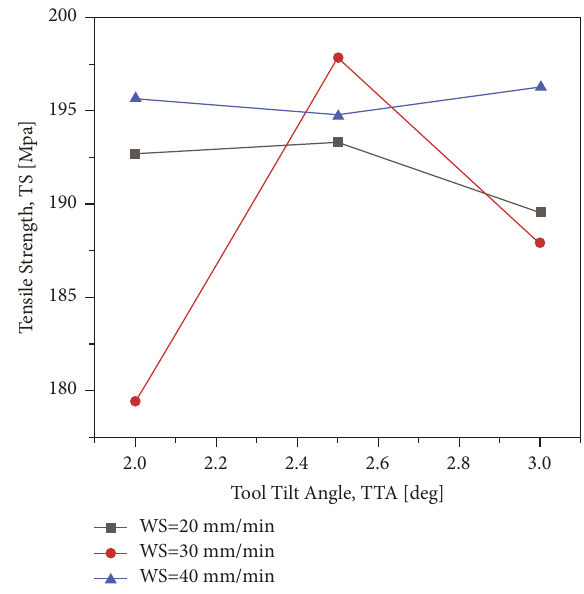
Figure 6: Influence of TRS -900 rpm on